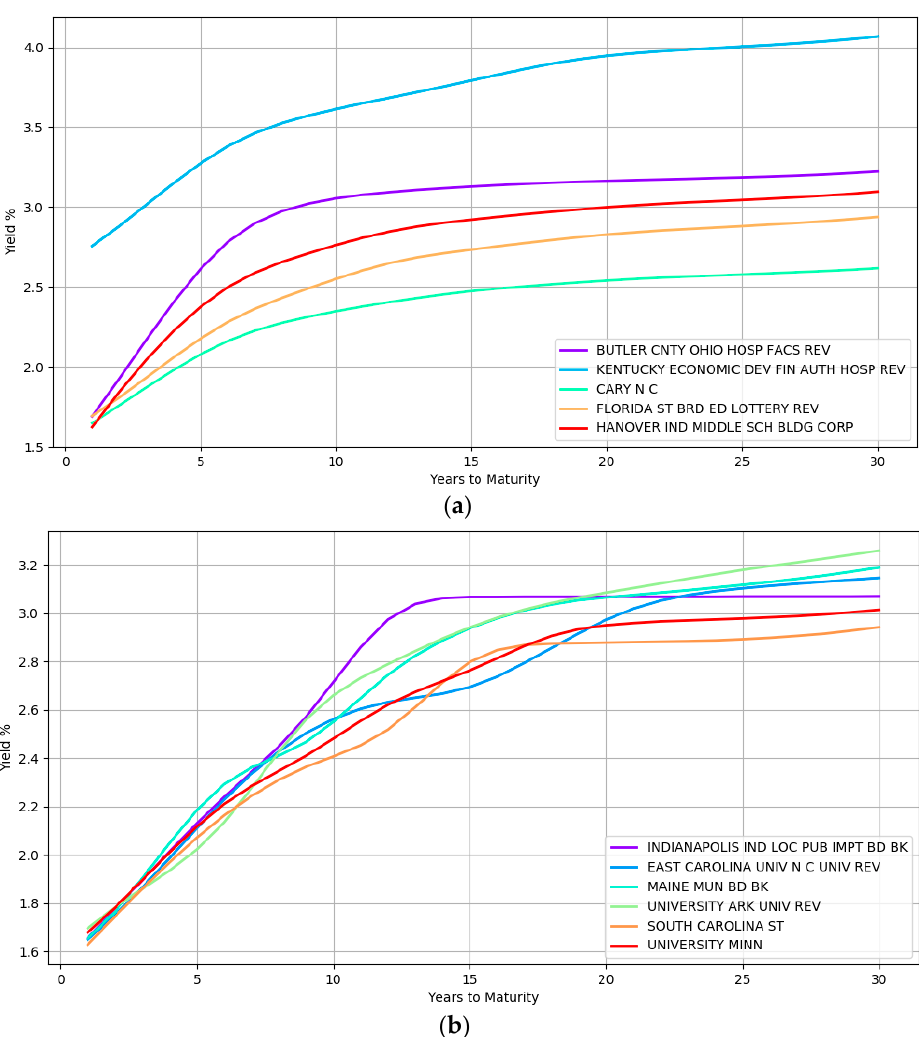
Figure 2. Yield curve shapes inferred by the model. ( a ): Simple shapes such as second order polynomial curves. ( b ): More complex shapes. Best viewed in color.